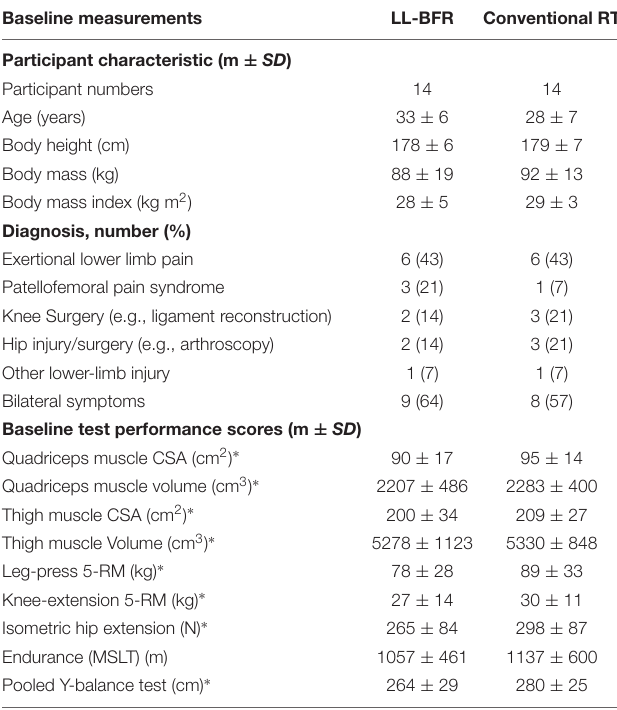
TABLE 2 | Descriptive characteristics, injury diagnosis, muscle CSA/volume, strength measurements and functional performance status recorded at